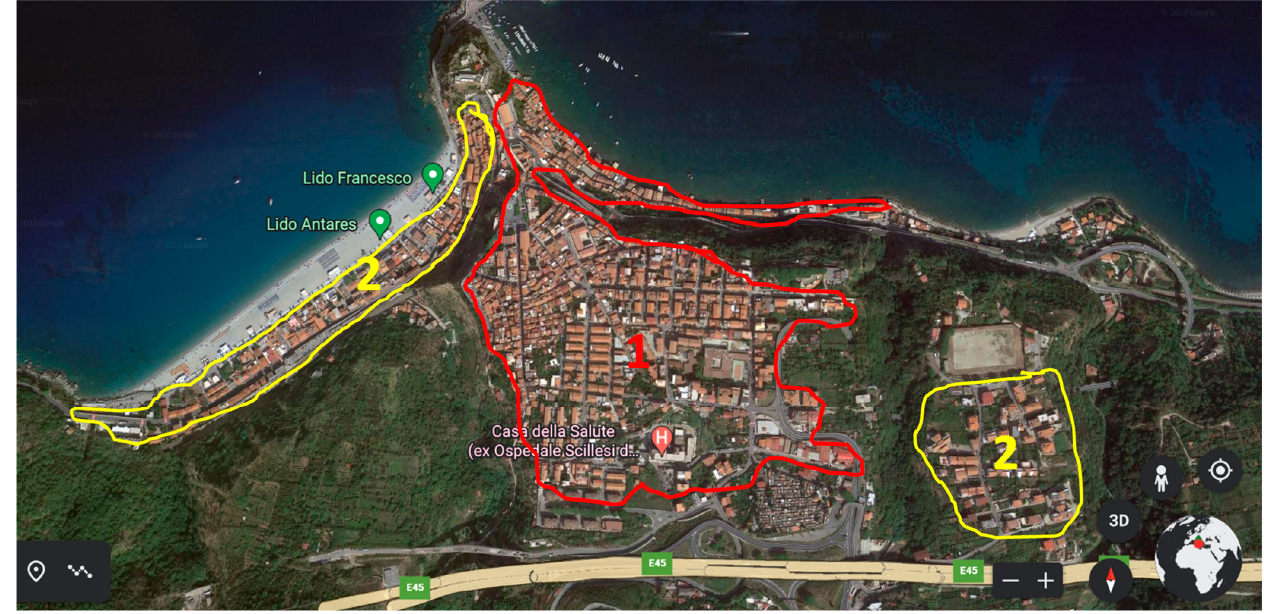
Figure 4. Google Maps view of Scilla subdivided into urban compartments.